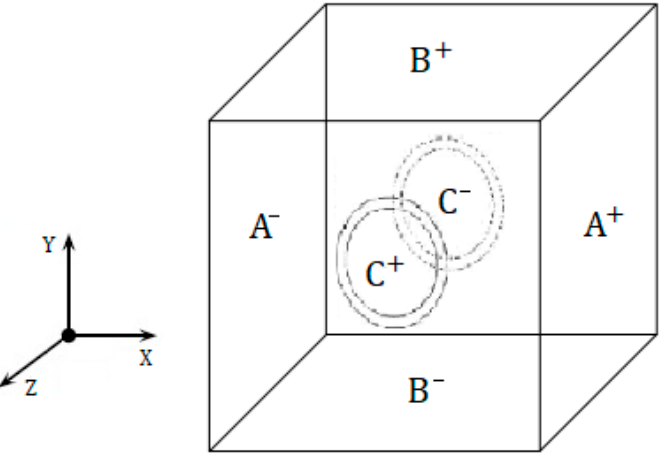
Figure 4. Notation of the RVE surfaces.